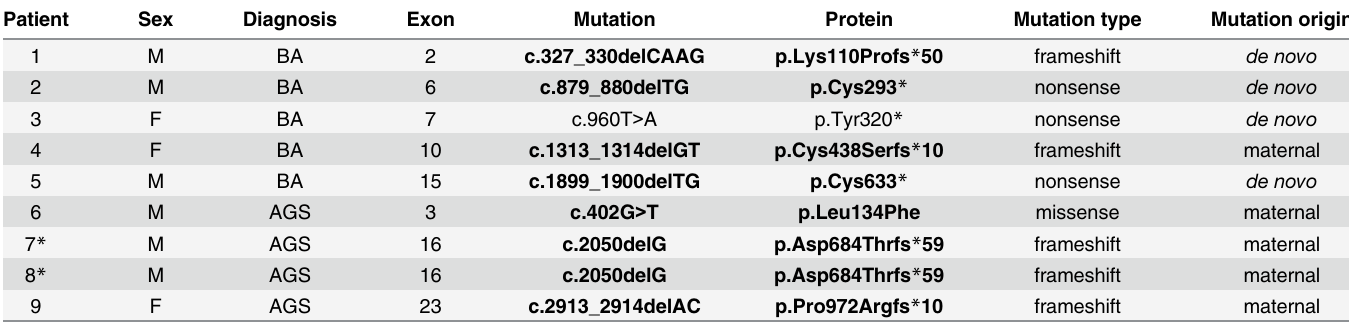
Table 1. Mutations in JAG1 found in patients with biliary atresia and Alagille syndrome. Patient